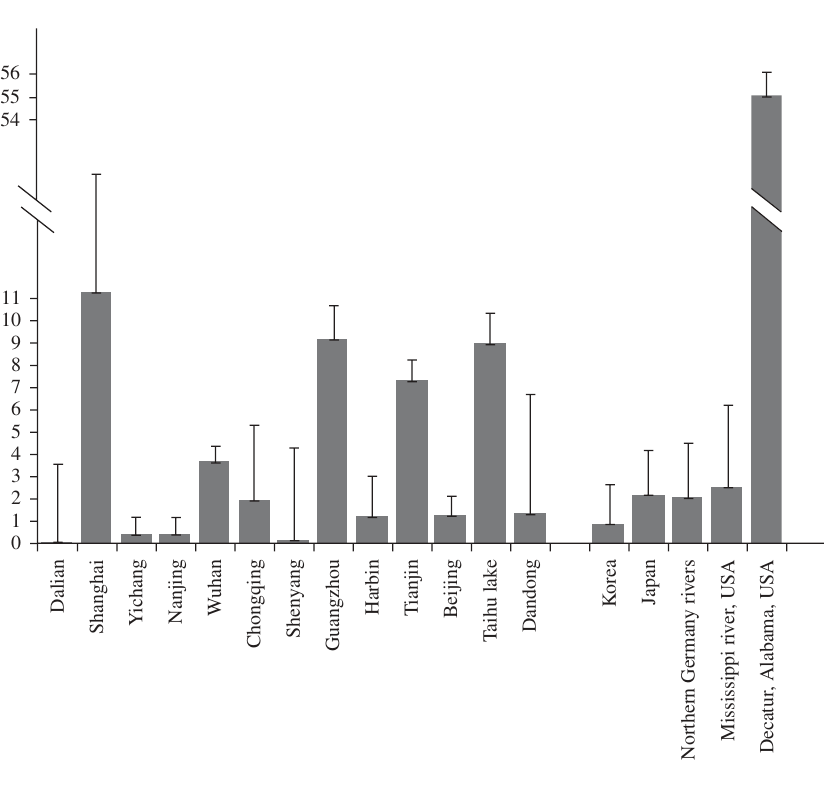
FIGURE 1: Comparison of geometric means of measured surface water PFOS concentrations in several Chinese cities versus those of Japan, Korea, USA, and Germany. Error bars represent standard